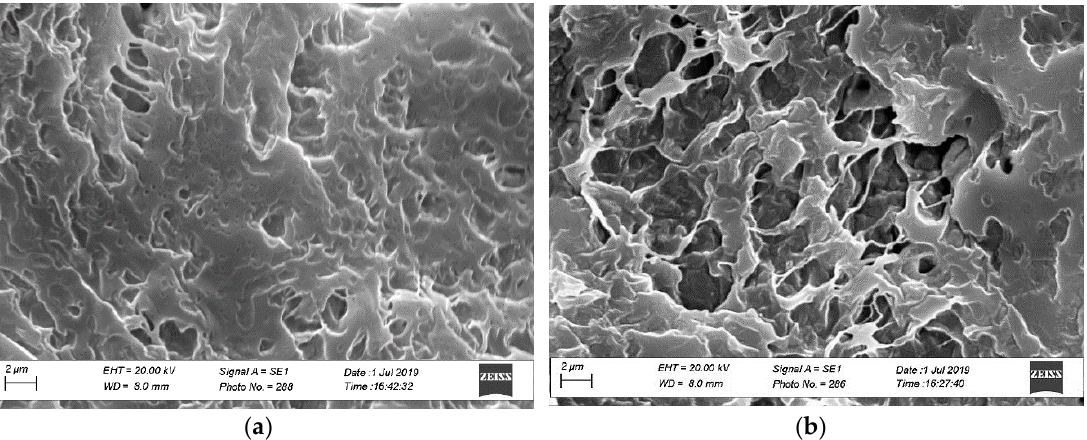
Figure 2. SEM of surface morphology and internal structure of a hydrophilic matrix ( a ) and hydrophilic matrix loaded with CUR-NLC and MTR ( b ). Bar = 2 μm.